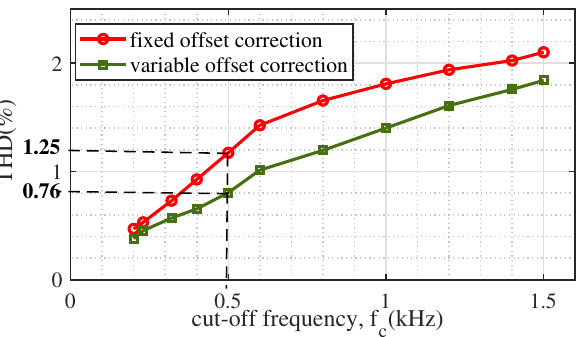
Figure 13. Relationship between THD and f c using the fixed and variable offset correction methods.